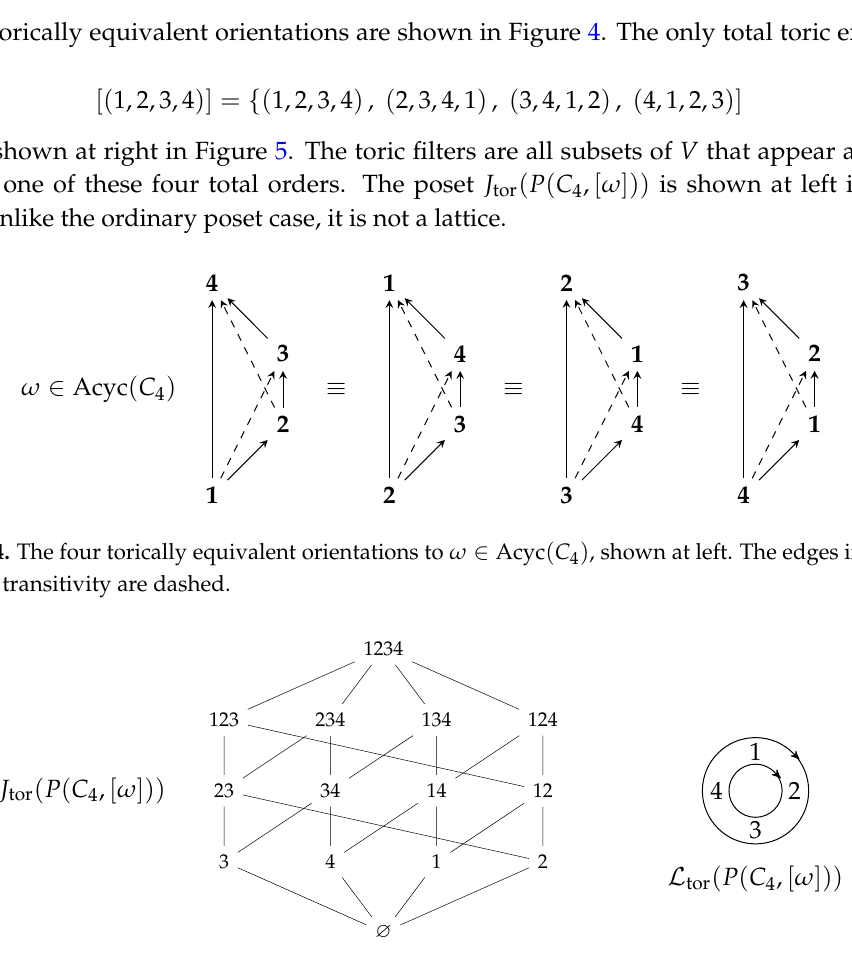
Figure 5. The toric filters of the toric poset P ( C 4 , [ ω ]) form a poset that is not a lattice. The vertices should be thought of as subsets of { 1,2,3,4 } ; order does not matter. That is, 134 represents { 1,3,4 }